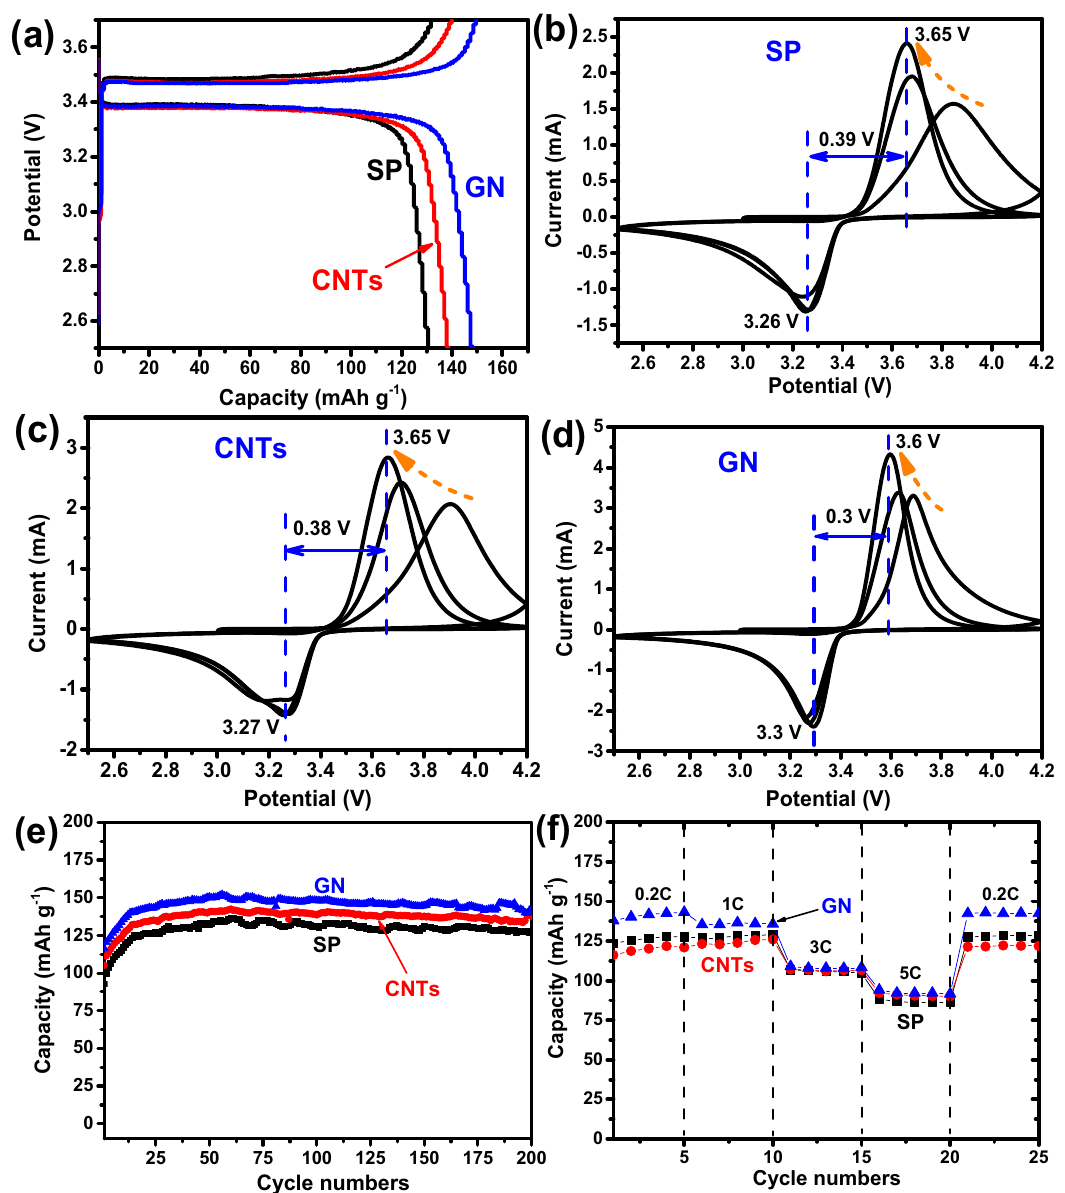
Figure 5: Electrochemical behavior of the LiFePO 4 cathodes with di ff erent unitary conductive agents: ( a ) charge/discharge pro fi les at 1 C; ( b – d ) CV curves; ( e ) cycling performance at 1 C; and ( f ) rate